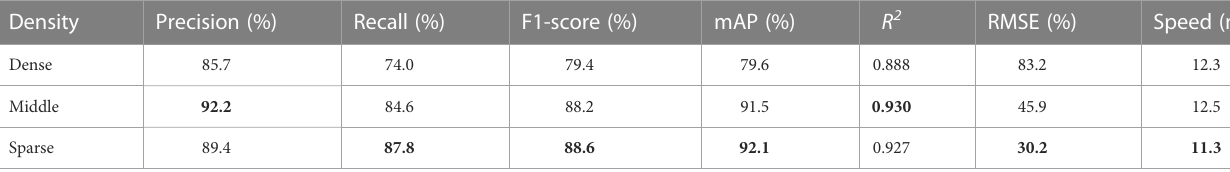
TABLE 4 Experimental results of the proposed method at different